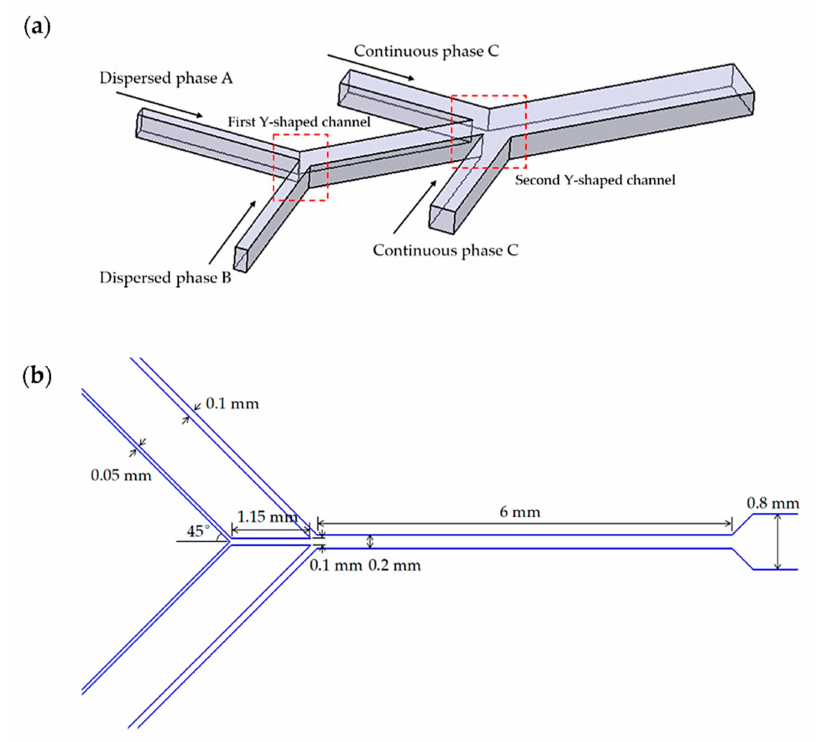
Figure 21. ( a ) Schematic illustration of the double Y-shaped channel used in the manufacture of Janus droplets; ( b ) Specific dimensions of each channel. Reprinted from an open-access source [80].